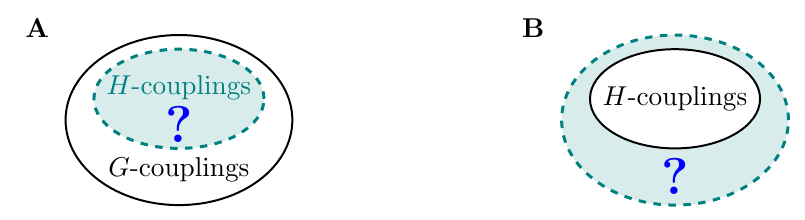
Figure 1 . Schematic diagrammatic representation of gauge invariant couplings. The smaller subset represent those couplings which up to a (cid:12)eld rede(cid:12)nition are gauge invariant o(cid:11)-shell. The bigger set represent instead the space of couplings whose gauge variation is proportional to the EoMs. It is important to note that there might in principle exist couplings which are not proportional to the EoMs and whose gauge transformation instead